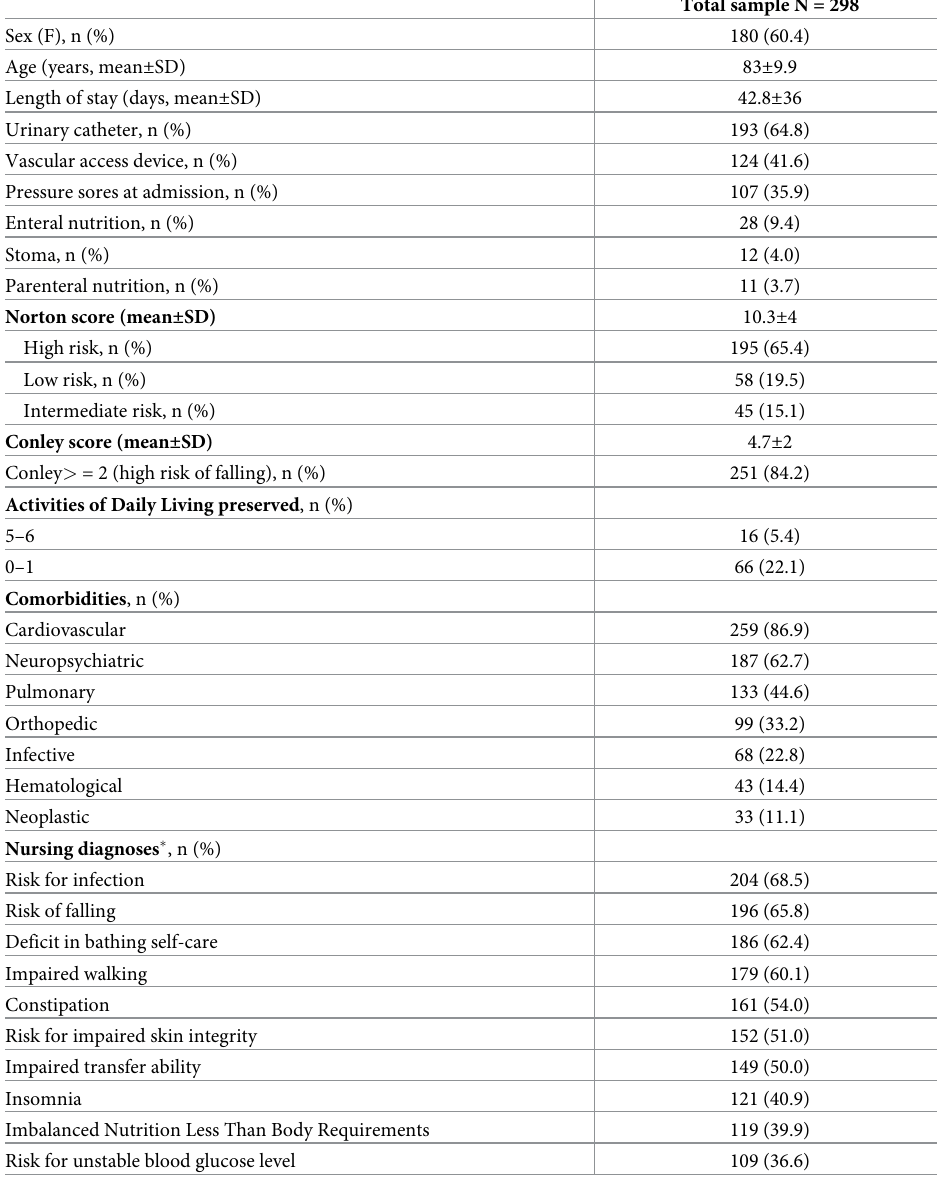
Table 1. Patients’ characteristics gathered using a multidimensional nursing